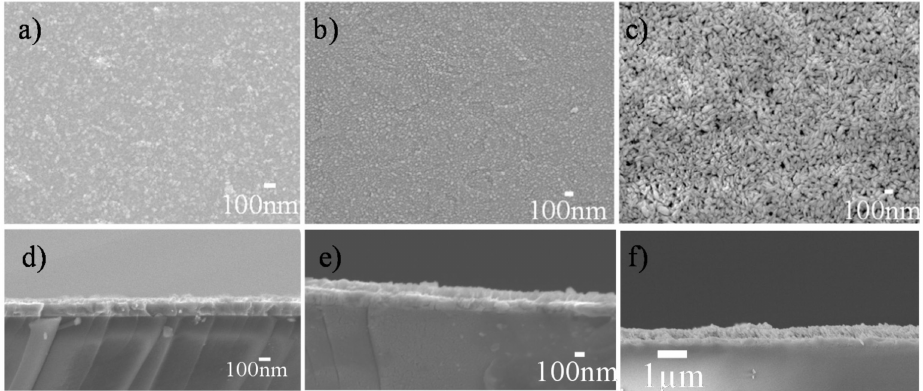
Figure 11. ( a – c ) Surface and ( d – f ) cross-sectional SEM images of HfO 2-EPD coatings prepared by EPD (5 V, 0.7 mA/cm 2 , 90 s) on ITO glass substrates using suspensions of ( a , d ) 5 nm, ( b , e ) 50 nm, and ( c , f ) 100 nm-sized HfO 2-NPs dispersed in an equimolar mixture of ethanol and acetylacetone at pH